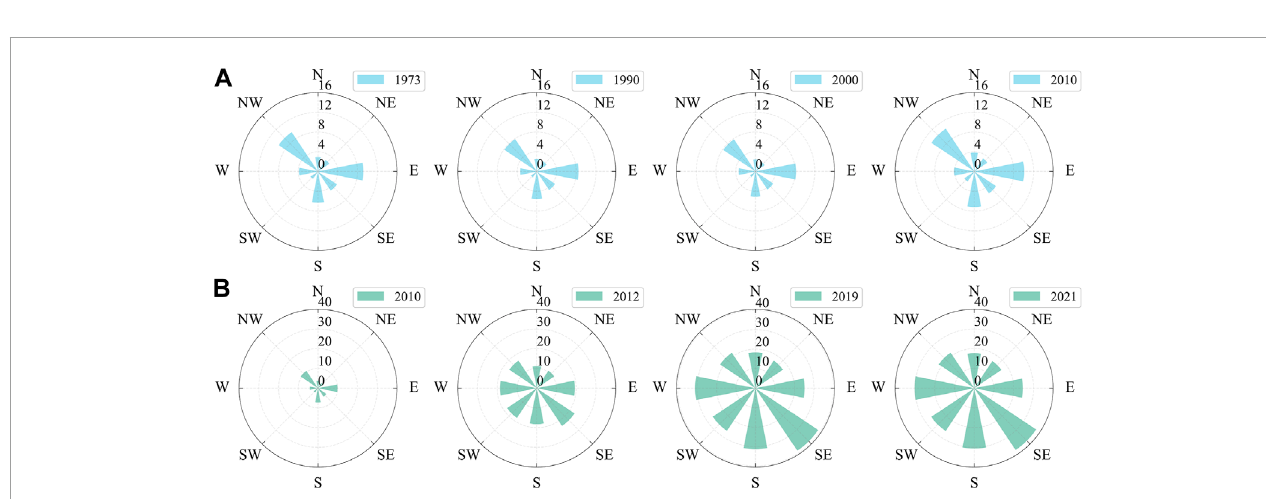
FIGURE 10 Changes in different directions of the Salt Lake before (A) and after (B) the outburst of the Zonag Lake.